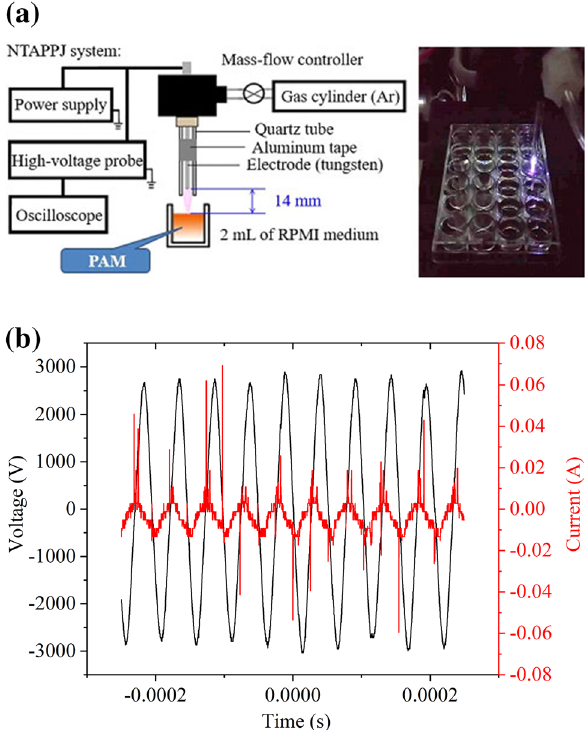
Figure 1. ( a ) Schematic and operation of PAM preparation. ( b ) Voltage and current waveforms of the plasma